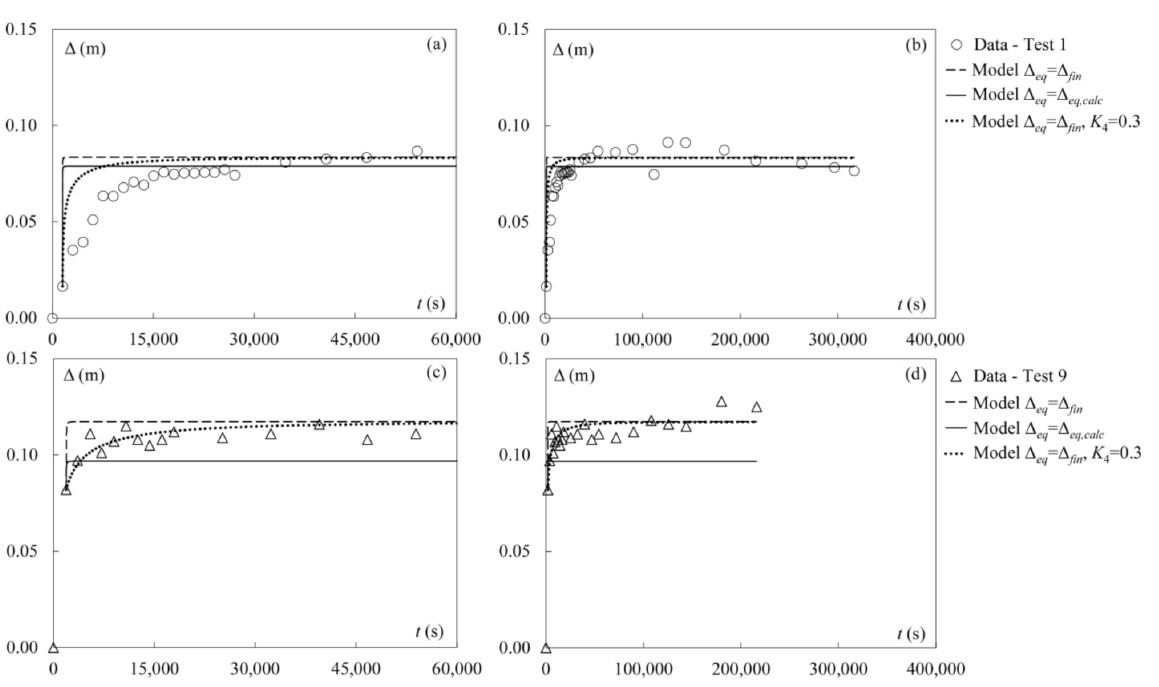
Figure 7. Comparison of numerical solutions of Equation (5) with experimental data pertaining to Test 1 ( a ) for t < 60,000 s (detailed view) and ( b ) total test duration, and Test 9 for ( c ) t < 60,000 s (detailed view) and ( d ) total test duration (data from Gaudio and Marion [1]). Numerical solutions were obtained assuming ∆ eq = ∆ fin (dashed line), ∆ eq = ∆ eq,calc (continuous line), and ∆ eq = ∆ fin and K 4 = 0.3 (dotted